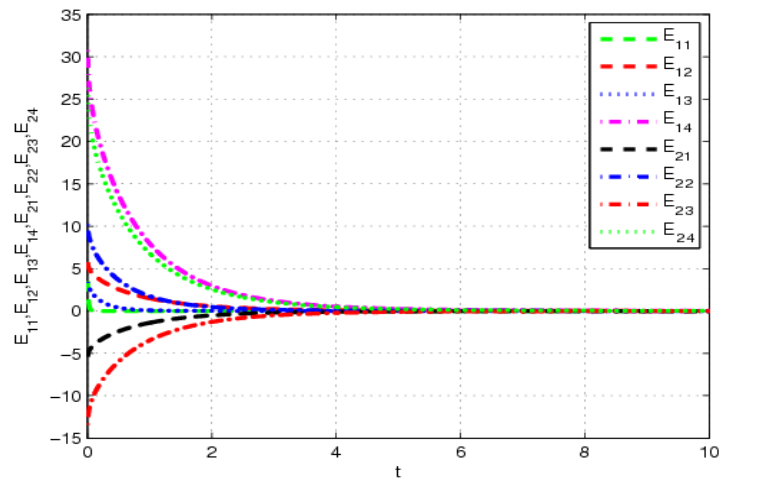
Figure 3. The error dynamics E ij ( t ) , i = 1,2, j = 1,2,3,4 of master and slave systems with controllers.